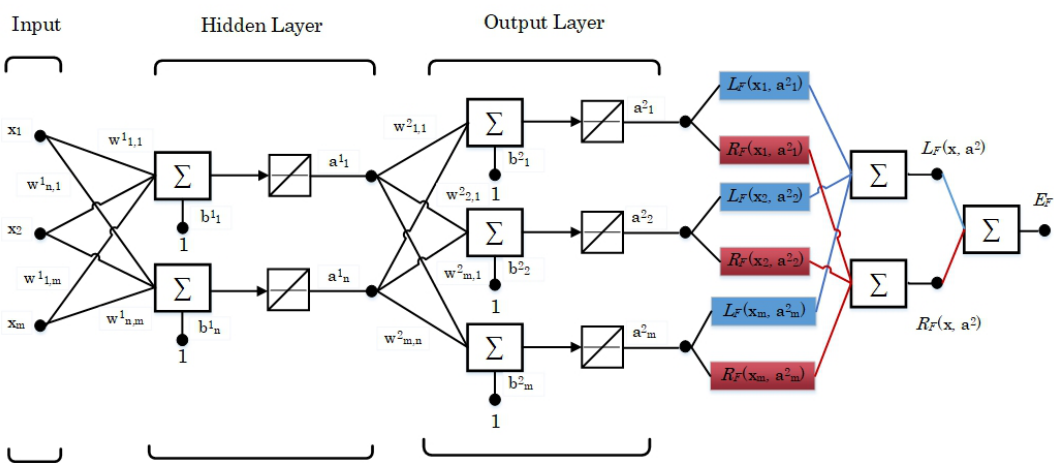
Figure 3. Example of sparse autoencoder approximation